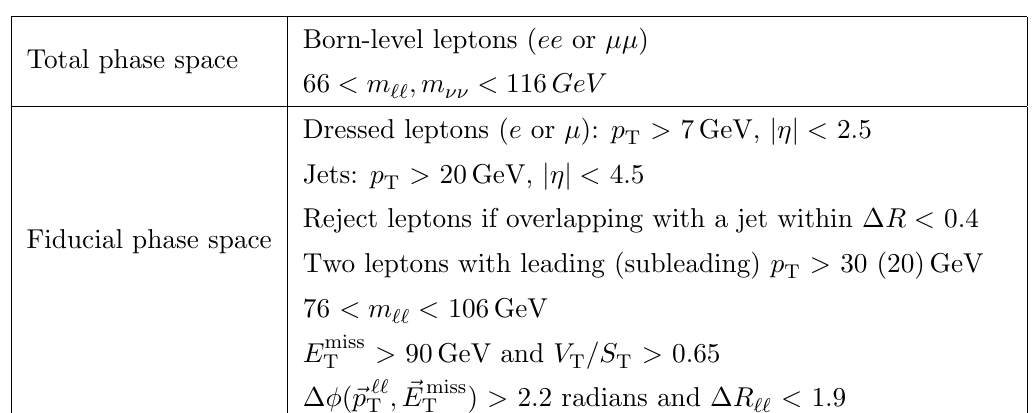
Table 3 . De(cid:12)nitions of the total and (cid:12)ducial phase spaces for the ZZ containing one or more b -jets are vetoed to further suppress the tt and W t